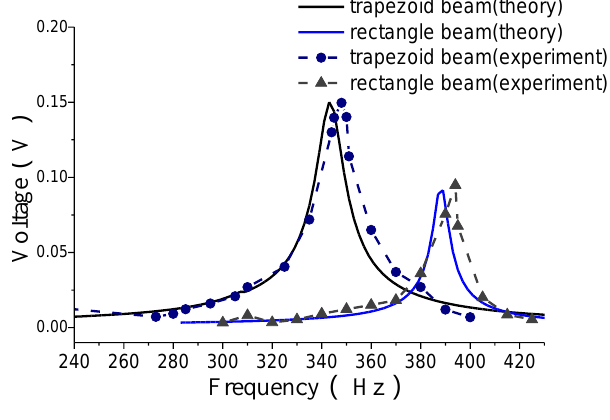
Figure 13. Open voltage outputs.